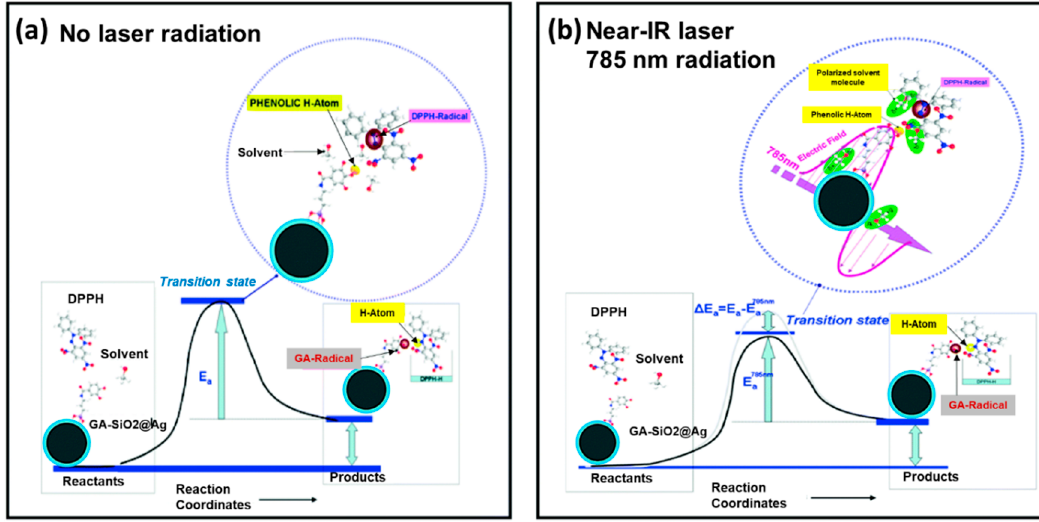
Figure 4. HAT mechanism from the phenolic OH of the conjugated GA of GA-SiO 2 @Ag nanoantioxidant to a DPPH radical under ( a ) no laser irradiation and ( b ) under 785 nm laser irradiation. The HAT mechanism / step proceeds via an activated transient state involving the association between DPPH • and GA. Upon 785 nm laser excitation at near-IR spectral region, a hot-spot was created by the agglomeration of the nanoparticles and a strong vibrational local electric field was produced, which lowers the activation energy (E a ) by at least 2 kcal mol − 1 . Adopted with permission from Ref. [63]. Copyright The Royal Society of Chemistry,